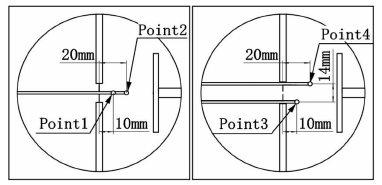
Figure 3. Position of the four measuring points.